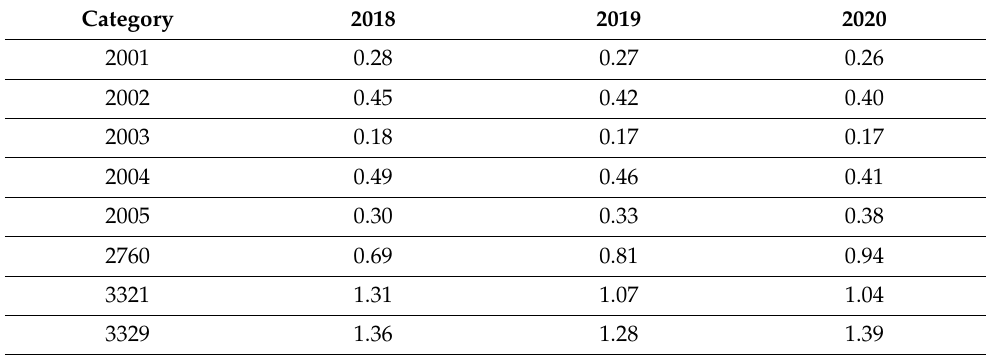
Table 5. Industrial Spatial Operation Preference